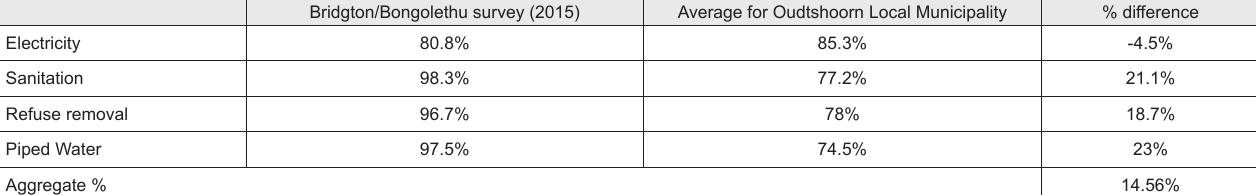
Service access for backyard respondents in study area vs average access in the Oudtshoorn Local